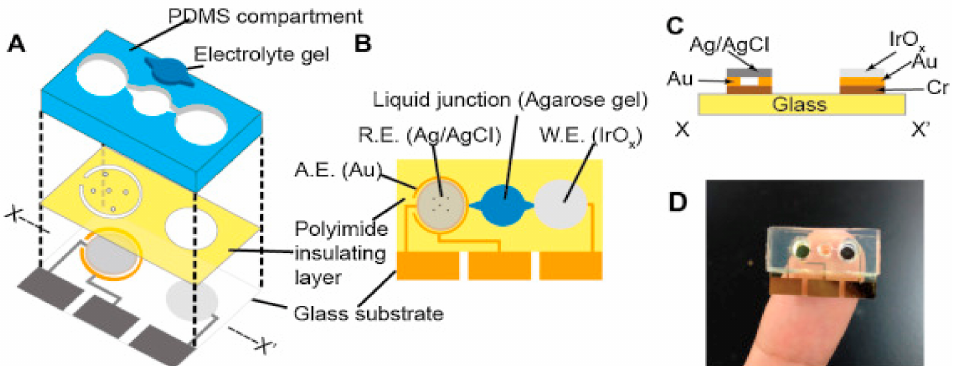
Figure 15. Construction of the device. ( A ) Expanded view of the device. ( B ) Top view showing the mutual relationship between the structures of the layers. ( C ) Cross-section along the X-X’ line in A. ( D ) The device on a finger. Planar dimensions are 20 mm × 11 mm. Reprinted with permission from reference [54]. Copyright 2015 Elsevier